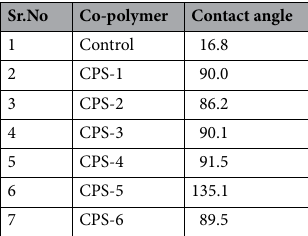
Table 5. Contact angle of water on glass slides CPS1-6.